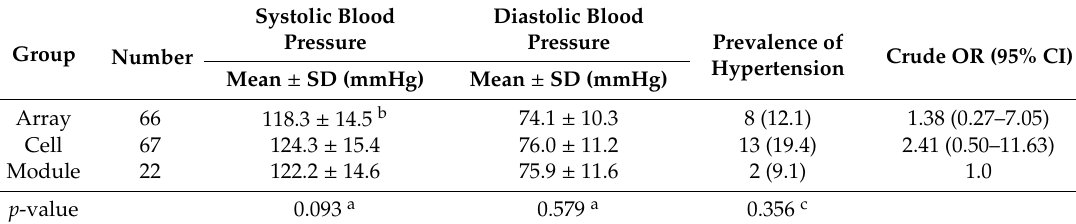
Table 3. Prevalence of hypertension and crude odds ratios (ORs) (95% CIs) by study group.